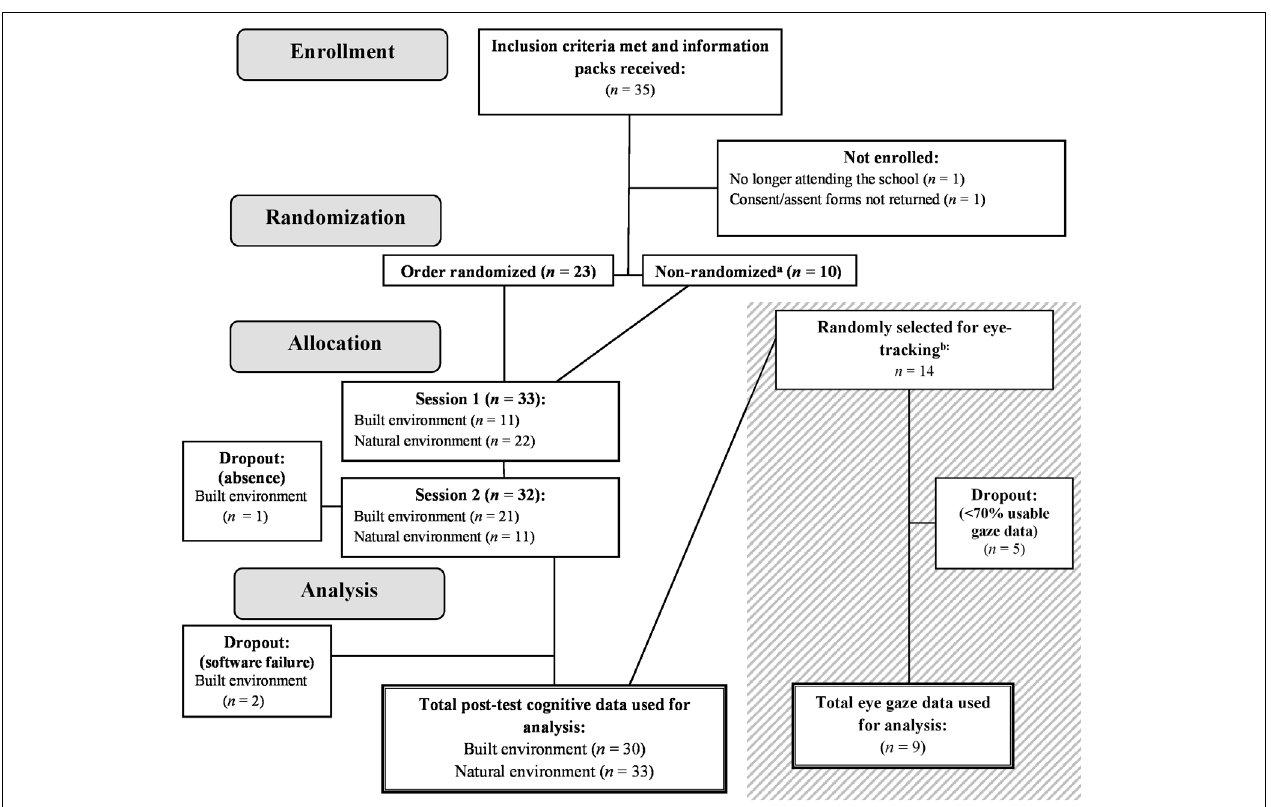
FIGURE 1 | CONSORT flow diagram. A CONSORT-inspired flowchart depicting participant numbers through phases of the study from recruitment to data analysis, including participant dropout points. The details of the eye-tracking data collection are presented in the gray box. a Computerized randomization of environment order was only possible for 23 out of 33 participants (69.7%) due to logistic restraints caused by the participants’ academic schedule. b Randomization of environment order for eye-tracking data collection was not possible for the same reason. All eye-tracking data were collected first in the natural environment, followed by the built environment